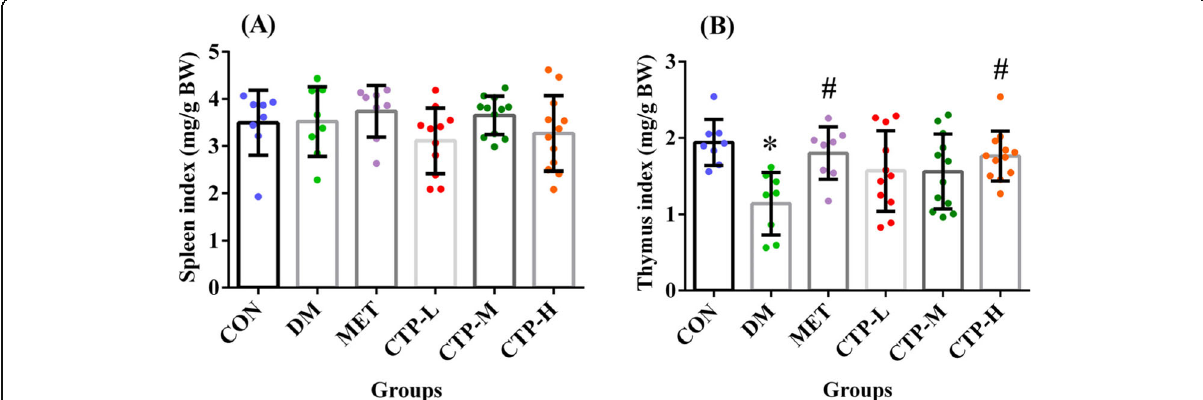
Fig. 5 Effects of CTP on immune organ indices in diabetic mice. The following indices were measured 28 days after CTP was administered ( a ) Spleen index. b Thymus index. Data are presented as the mean ± SD ( n = 8 – 12). * p < 0.05 as compared with CON. # p < 0.05 as compared with DM